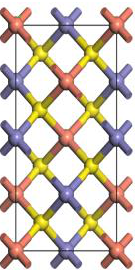
Figure 1. Unit cell of chalcopyrite. Red represents Cu atom, blue represents Fe atom, and yellow represents S atom.